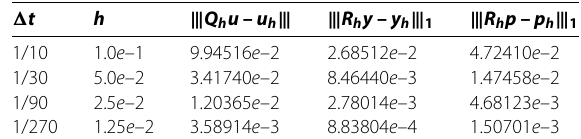
Table 1 The errors of Example 1